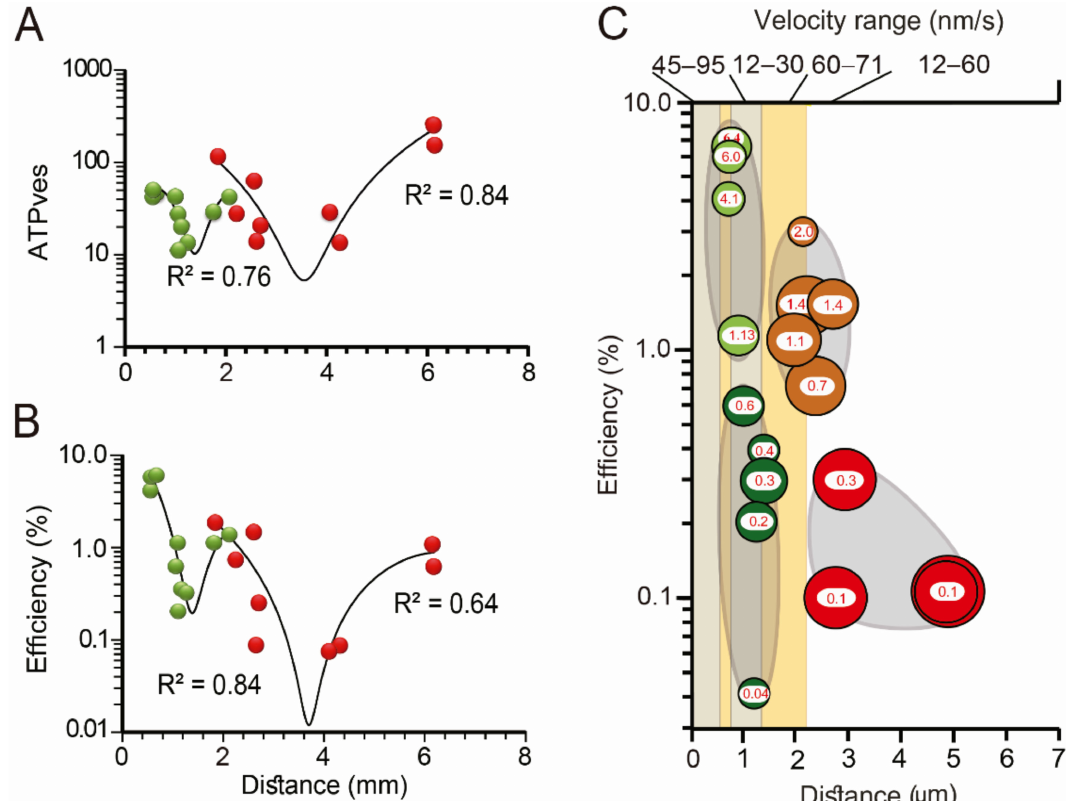
Figure 12. Structural and biophysical correlates of the thermodynamic efficiency of the ATP hy- drolysis during vesicle transport. The ATP cost per vesicle fused ( A ) and the thermodynamic efficiency ( B ) depend on the travelling distance of the vesicle clusters. Distances were calculated from model fittings to the exocytosis kinetics in combination with electron microscopy measurements. ( C ) Peripheral (green) and internal (red) vesicle clusters are grouped according to their thermody- namic efficiency, size, distance from the plasma membrane and transport velocity. The thermody- namic efficiency of somatic exocytosis (% inside vesicle clusters) correlated with the thickness of the actin cortex (pale orange) and with the position of both layers of endoplasmic reticulum (gray bars). The cluster diameters are proportional to the number of vesicles that fused in each cluster.